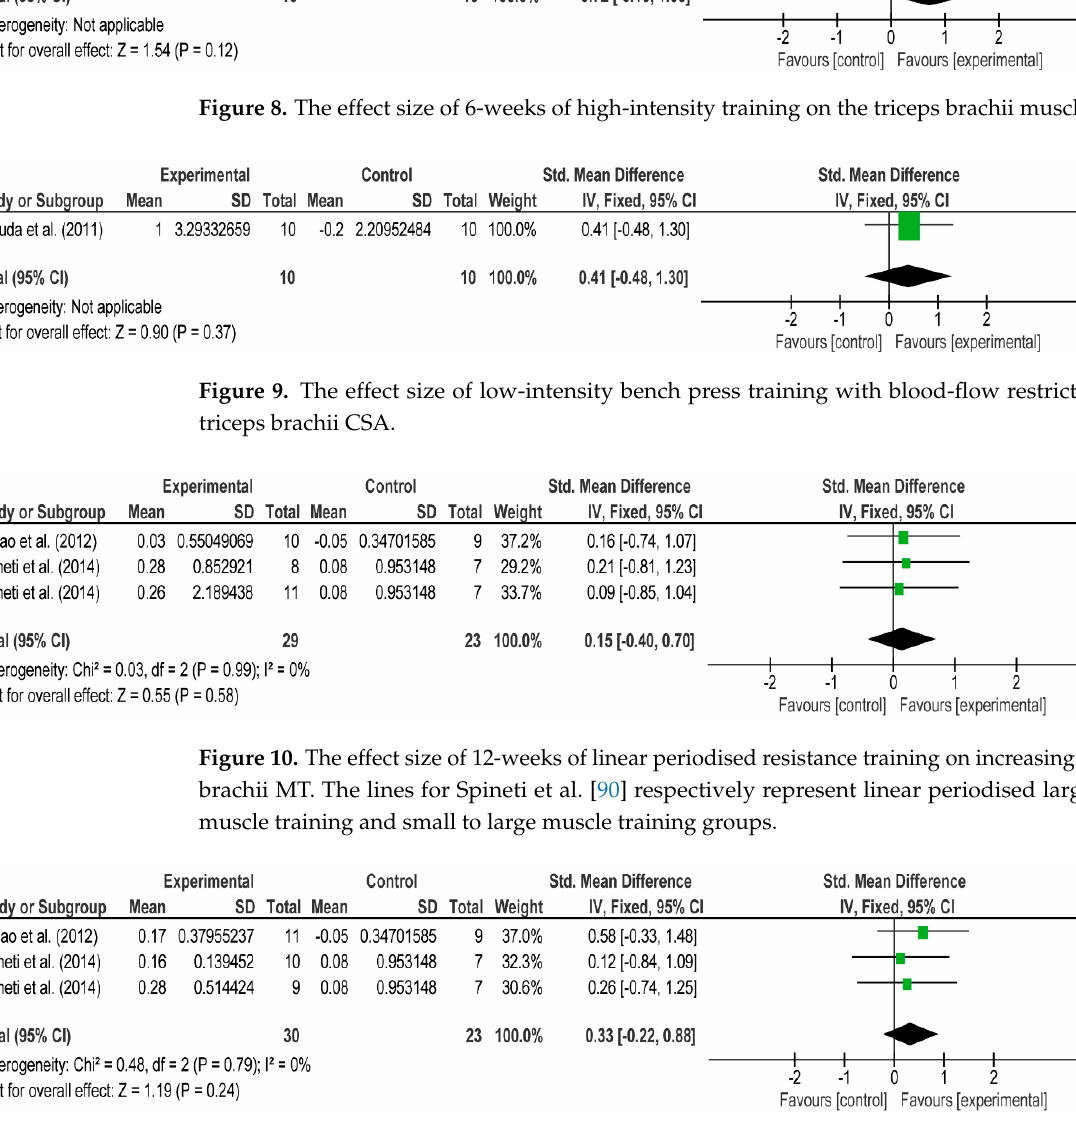
Figure 11. The effect size of 12 –weeks of nonlinear periodised resistance training on increasing the triceps brachii MT. The lines for Spineti et al. [90] respectively represent nonlinear periodised large to small muscle training and small to large muscle training groups.